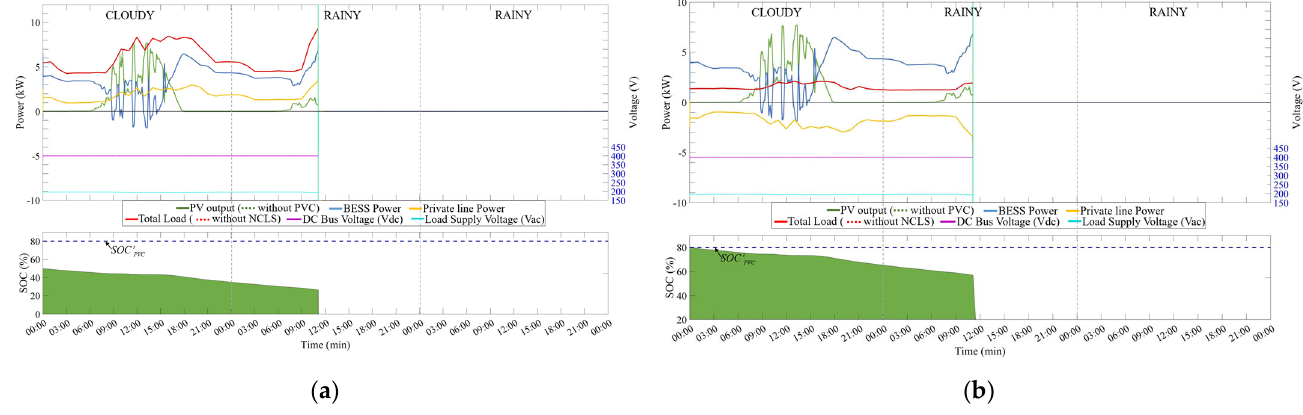
Figure 12. Test case 3 (Connected). ( a ) Performance of prosumer X. ( b ) Performance of prosumer Y.